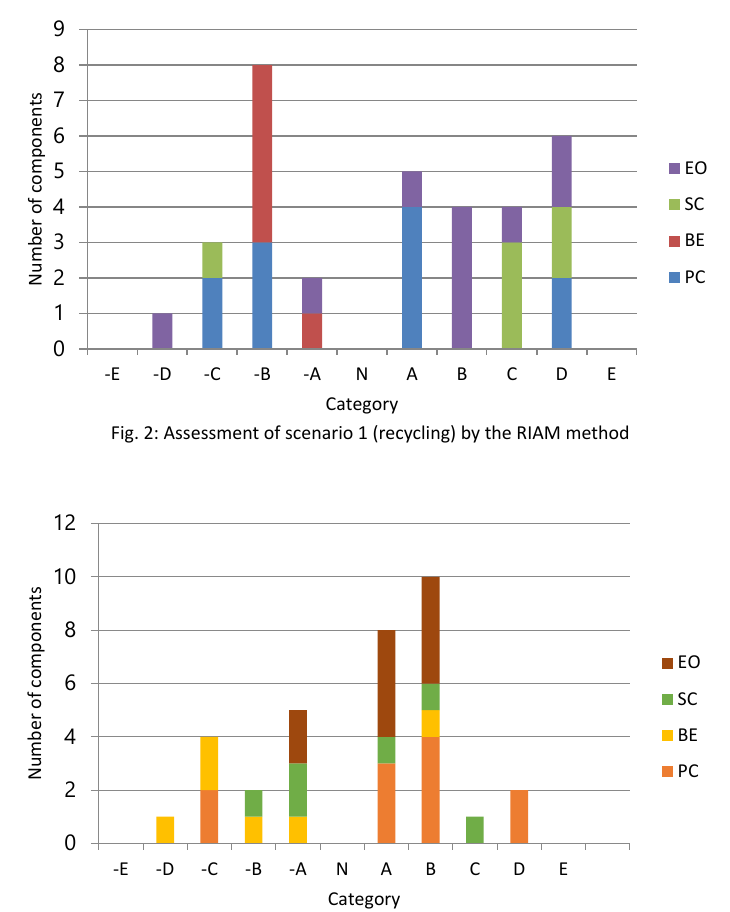
Fig. 3: Assessment of scenario 2 (sanitary landfill) by the RIAM method